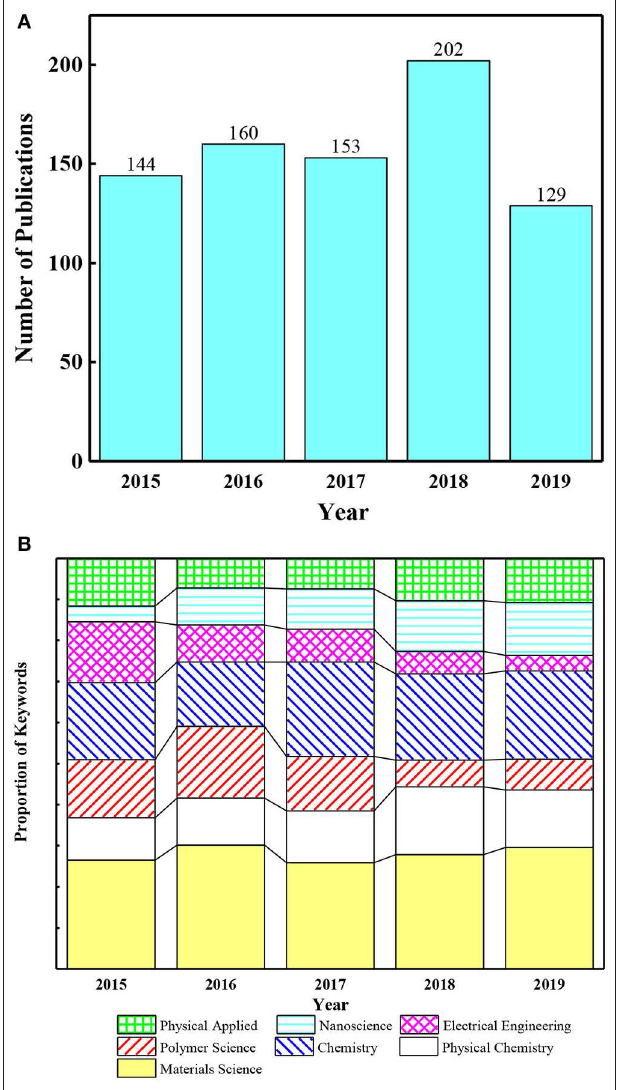
FIGURE 1 | (A) Number of publications during the last 5 years (data from WOS to August 2019). (B) Recent research hotspots in IPMC.